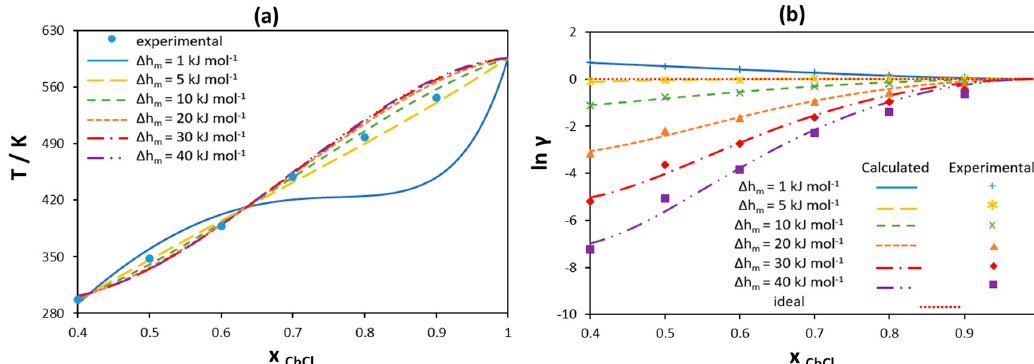
Figure 8. ( a ) Liquidus line of [Ch]Cl in a [Ch]Cl/choline acetate binary mixture modeled using the RK-polynomial assuming different melting enthalpy values. ( b ) Activity coefficients of [Ch]Cl in the liquid phase calculated using the RK-polynomial assuming different melting enthalpy values. Melting temperature of [Ch]Cl is assumed to be 597 K. Experimental data are taken from